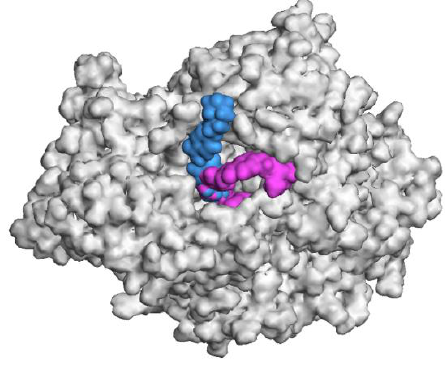
Figure 3. 3D surface representation of compounds 4 (pink), 6 (blue) and h AChE (white).